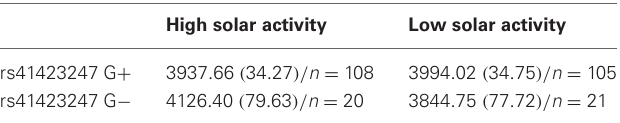
Table 1 | Interaction effect of rs41423247 (G ± ) by solar activity in the first trimester (high/low) on the left hippocampus volume (means and SEM are presented).